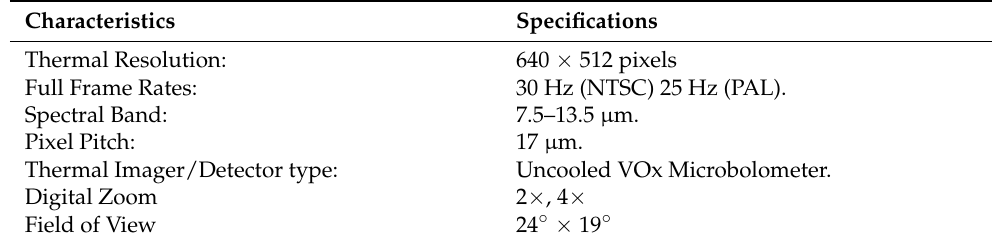
Table 4. UAS and IR camera specifications.